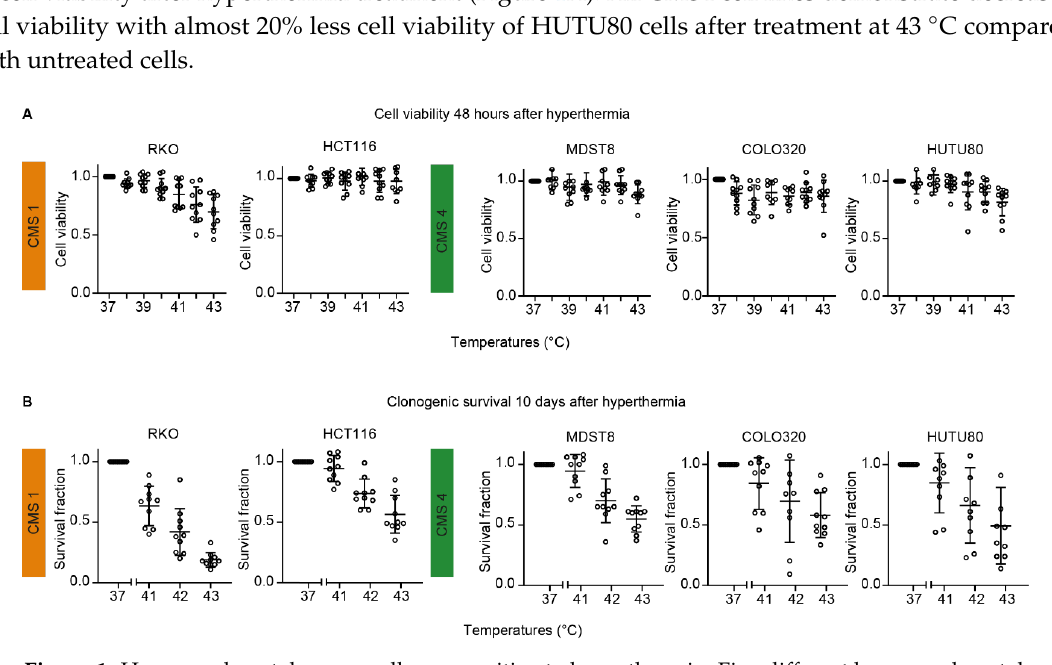
Figure 1. Human colorectal cancer cells are sensitive to hyperthermia. Five different human colorectal cancer cell lines: RKO, HCT116, MDST8, COLO320, and HUTU80, were used to study the sensitivity